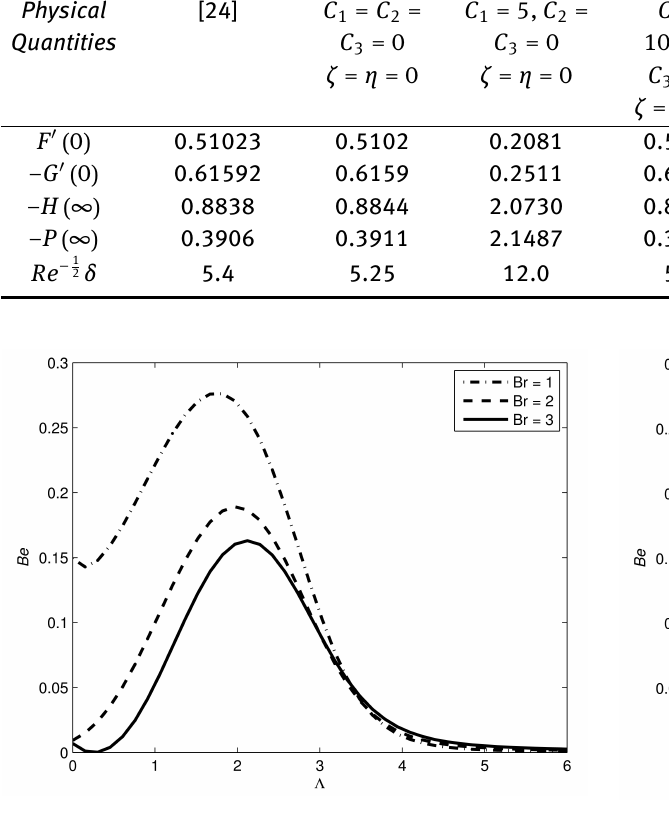
Figure 24: Effect of Br on Be keeping ζ = η = 0.2 , C 1 = C 2 = C 3 =